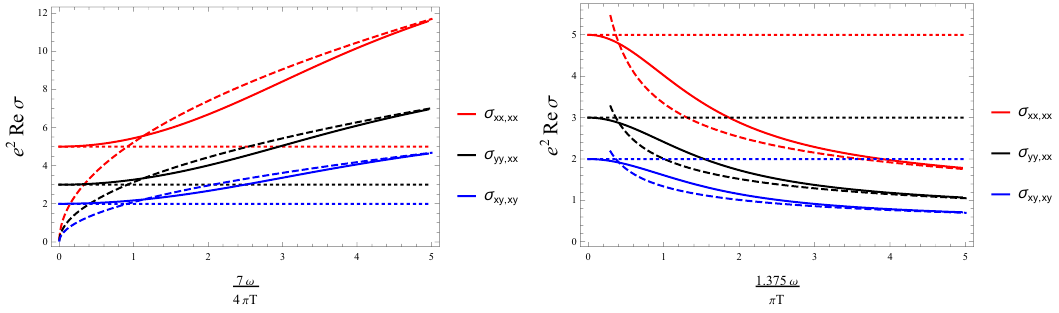
Figure 1 . Real part of frequency-dependent conductivity for the theory described by (3.3) (dotted and dashed lines corresponds to the limiting cases ω = 0 and ω −→ ∞ respectively). Left: conduc- tivity contribution from each channel for d = 5 , θ = 0 , z = 2 , C 1 = 2 , C 2 = 3 . Right: conductivity contribution from each channel for d = 3 , θ = 0 , z = 5 , C 1 = 2 , C 2 = 3 2